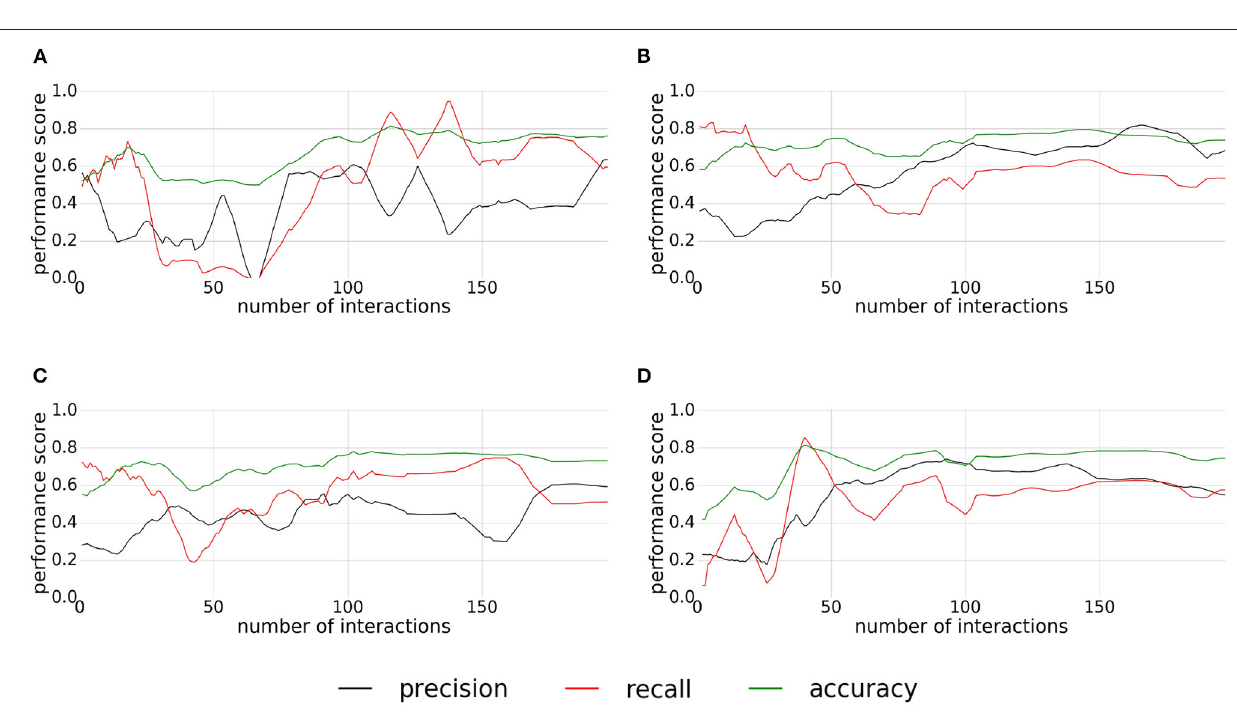
the best performing classifier among the experiments and at the best moment inside a replication. Only supervoxels of both relevance maps with a probability equal or higher of 0.5 are